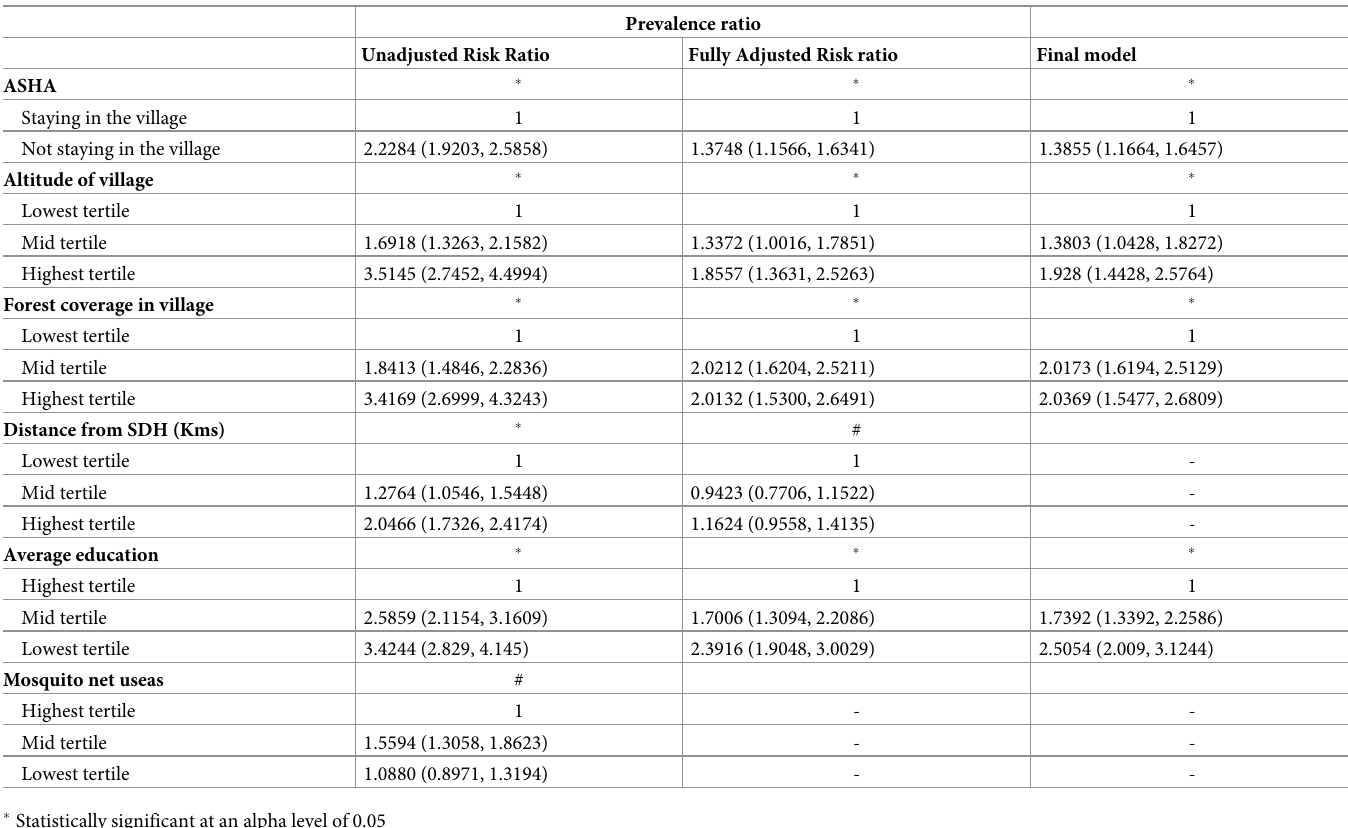
Table 3. Association of village characteristics with prevalence of